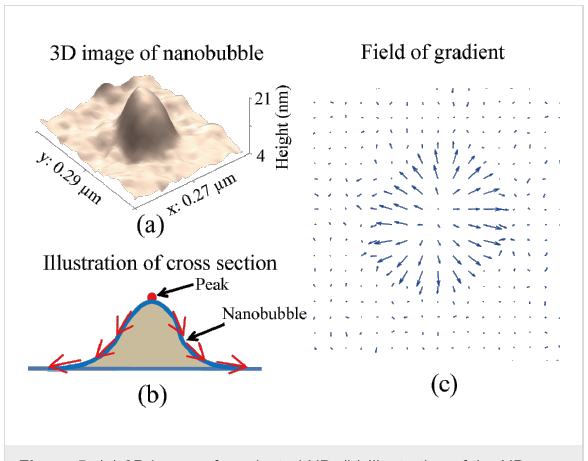
Figure 5: (a) 3D image of a selected NB. (b) Illustration of the NB cross section. (c) Field of gradient of the AFM image.